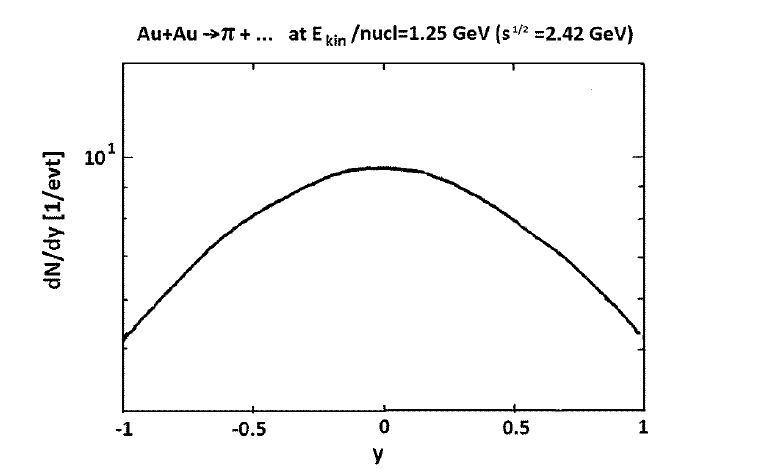
Figure 1. Distribution of secondary pions in Au + Au collisions as function of the pion rapidity